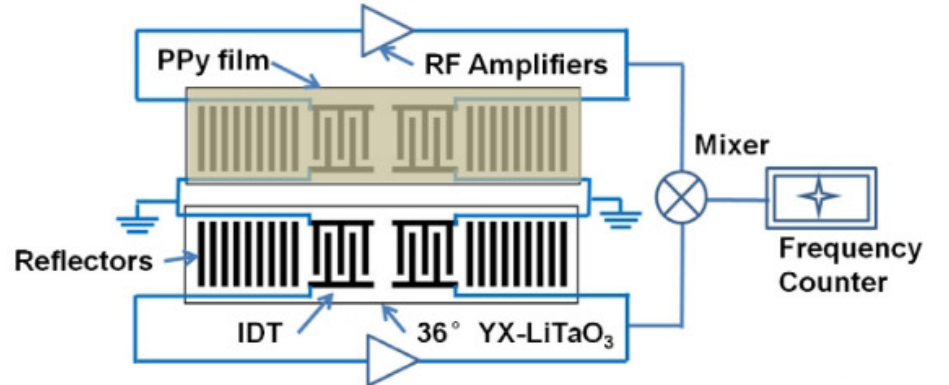
Figure 10. Schematic of the SAW-based sensor with PPy nanoparticles. (Reprinted with permission from [82]. Copyright 2013